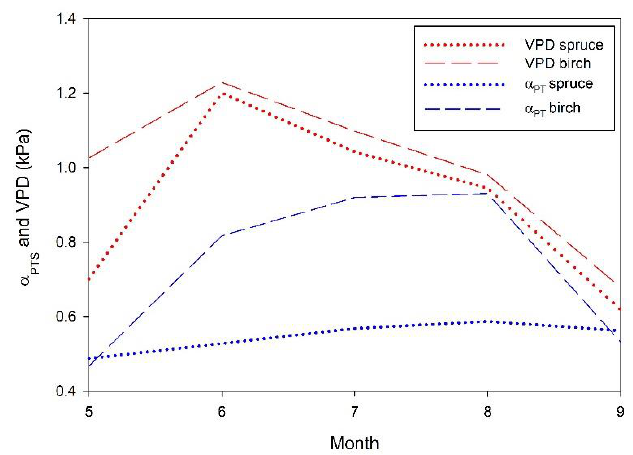
Figure 5. Vapour pressure deficit (VPD, in kPa) and α PTS daytime monthly averages from May to September for the 2012–2016 period computed using the flux tower data at birch and black spruce flux towers.